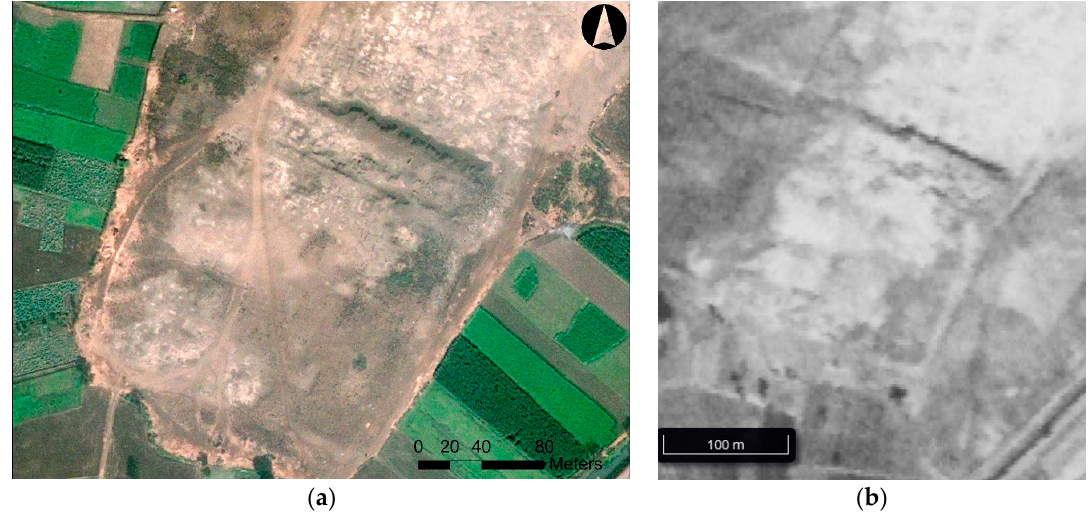
Figure 7. ( a ) The site of Abu Mitawi. Image courtesy Google Earth; ( b ) 1968 CORONA image. Image courtesy of the Center for Advanced Spatial Technologies, University of Arkansas/U.S. Geological Survey.